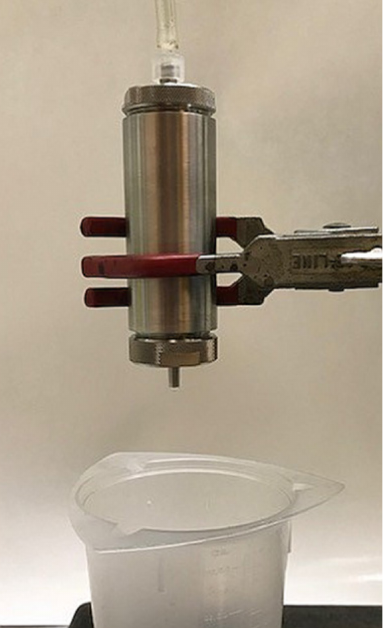
Fig. 1 Stainless steel, one inch diameter pressure filtration